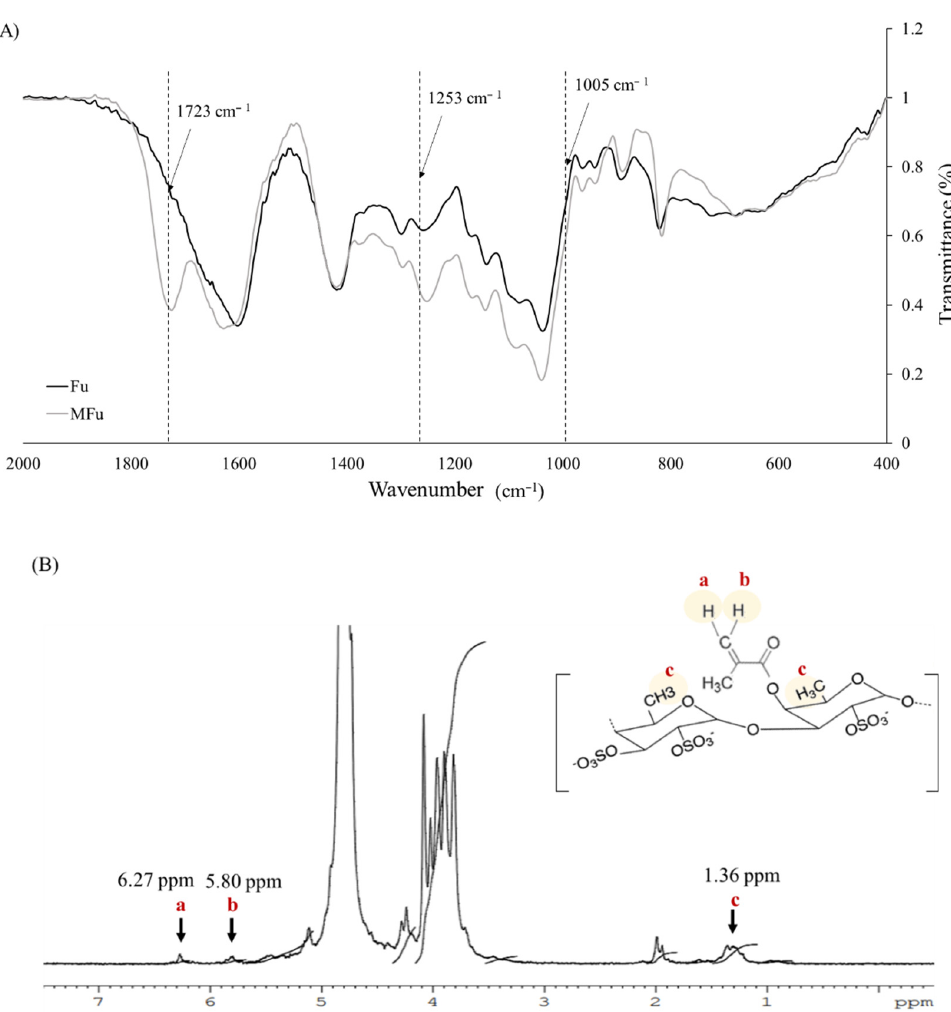
Figure 3. FTIR spectra ( A ) and 1 H NMR spectra ( B ) of fucoidan (Fu) and methacrylate-fucoidan